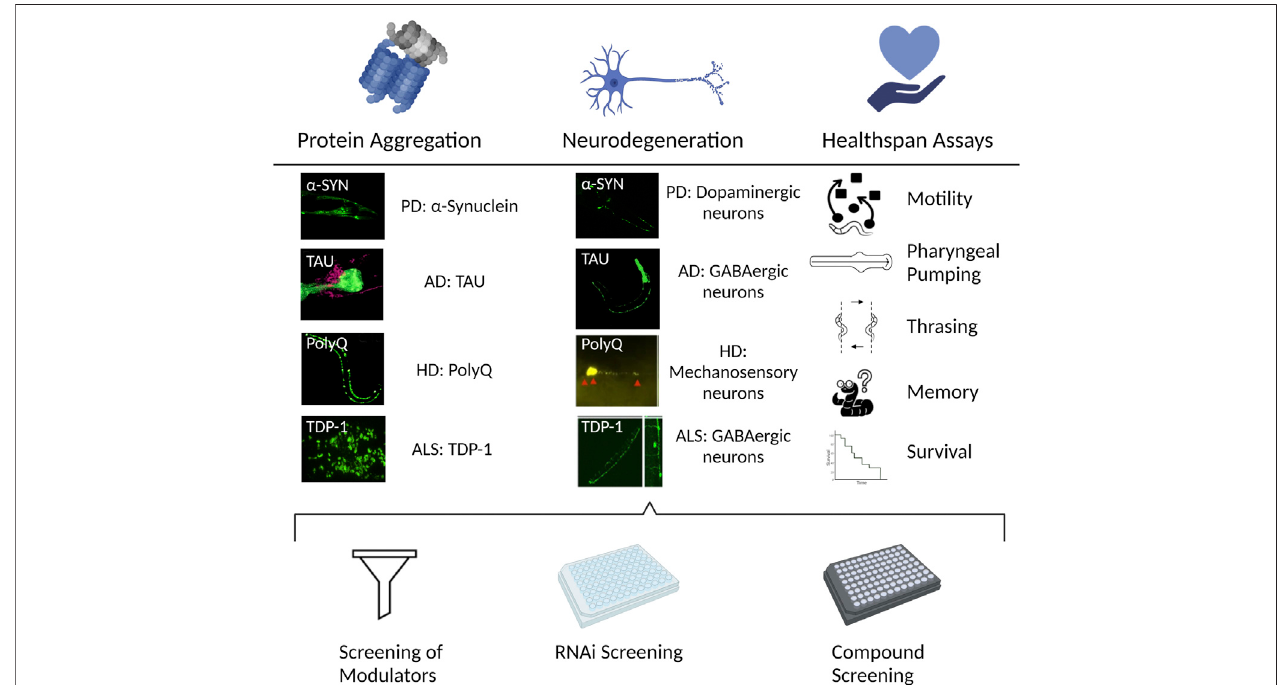
FIGURE 4 | C. elegans to study NDs. The nematode allows for different perspectives in the study and understanding of NDs. Left . Protein misfolding and aggregation is one of the common features of different NDs. The transparency of C. elegans in combination with the use of fl uorescent tags allows for the in vivo visualization of the protein aggregation process in the NDs of interest. Center . A consequence of the progression of NDs is the degeneration of the affected neurons. Strainscanbeengineeredtoexpresstheaggregating proteins intheneuronalcircuitofinterestinthenematode, allowingtostudytheneurodegenerationprocess. Right. Themorphologicalchanges,featuredinthedifferentNDmodelslikeaggregationorneurodegeneration,alsotranslateintofunctionalchallenges.Theperformance in thedifferentavailableassayscorresponds tothe healthstatus oftheneuron/s ofinterest. Bottom. Theabove-mentioned assessments ofanNDusing C.elegans can be combined with available mutant strains for the gene/s of interest, or with screenings, either with the available existing RNAi libraries, to fi nd genetic modulators; or compound screenings where chemical regulators of the ND progression can be discovered. The fi gure has been generated using Biorender.com by the author.